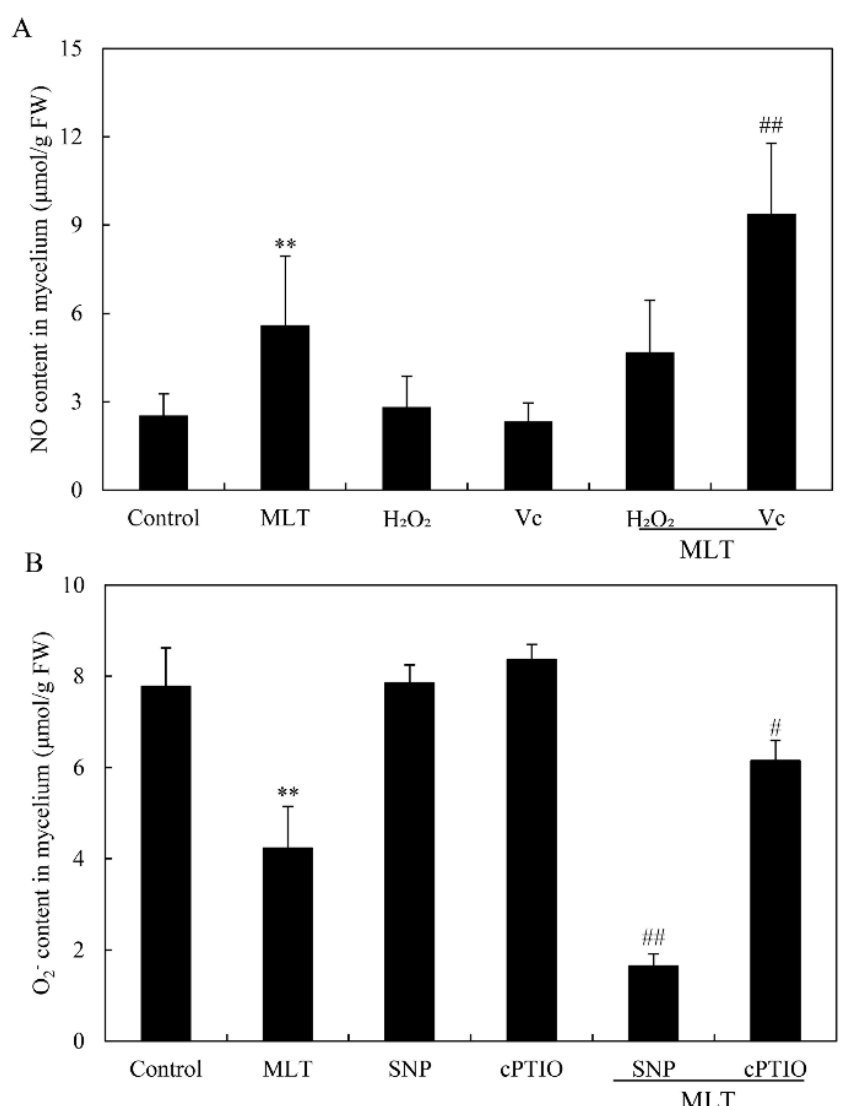
Figure 6. Effect of melatonin (MLT) on NO ( A ) and O 2 − contents ( B ) in the cultures of Shiraia sp. S9 and the influence of the donor and scavengers of NO and ROS. The culture was maintained in a 150 mL flask containing 50 mL medium at 150 r/min and 28 ◦ C under a light/dark shift (24 h:24 h). MLT at 100.00 µ M was added on day 2. H 2 O 2 (100 µ M), Vc (10 µ M), SNP (10 µ M) and cPTIO (100 µ M) were added 30 min prior to MLT, and the contents were detected after 24 h of MLT treatment. Values are mean ± SD from three independent experiments (** p < 0.01 vs. control. # p < 0.05 and ## p < 0.01 vs. MLT treatment).